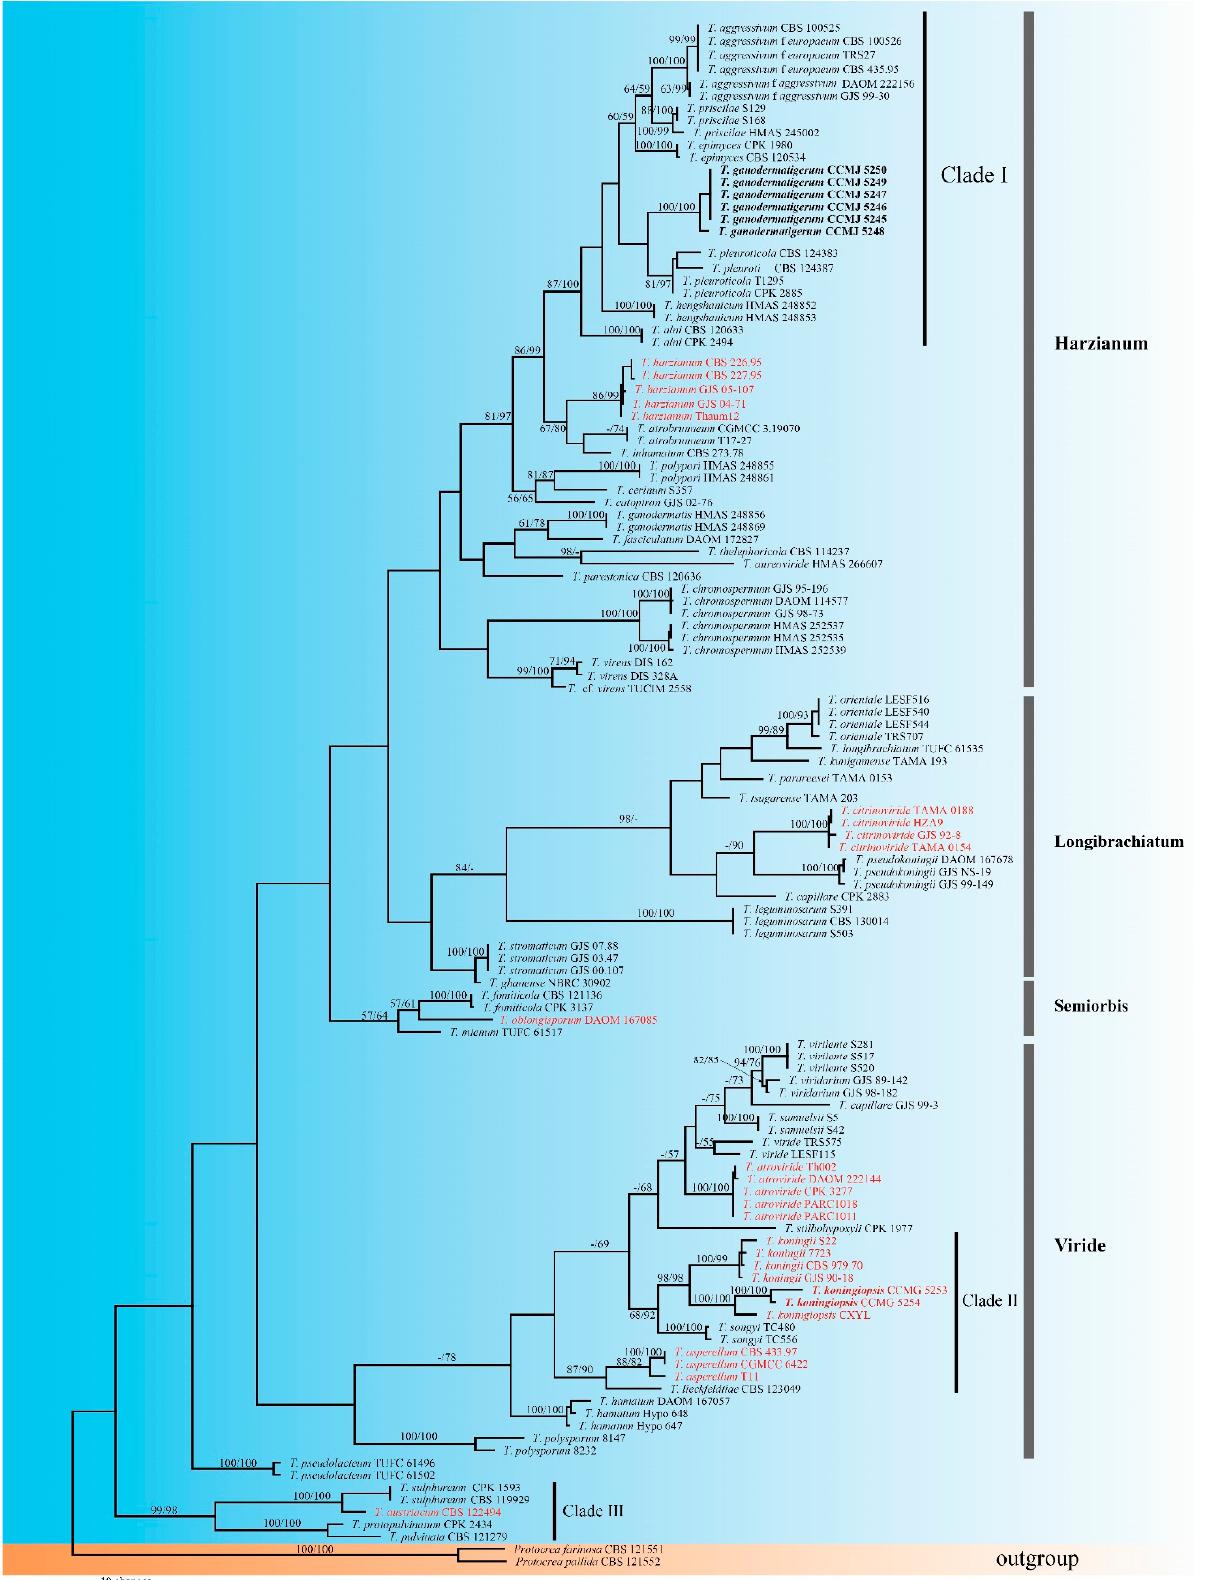
Figure 2. Phylogeny of Trichoderma associated with mushrooms using MP analysis based on concatenated TEF1 and RPB2 sequences. Branches are labeled with MPBP ≥ 50% and MLBP ≥ 50%. The biological agents are marked in red, and the new sequences in this study are in bold.